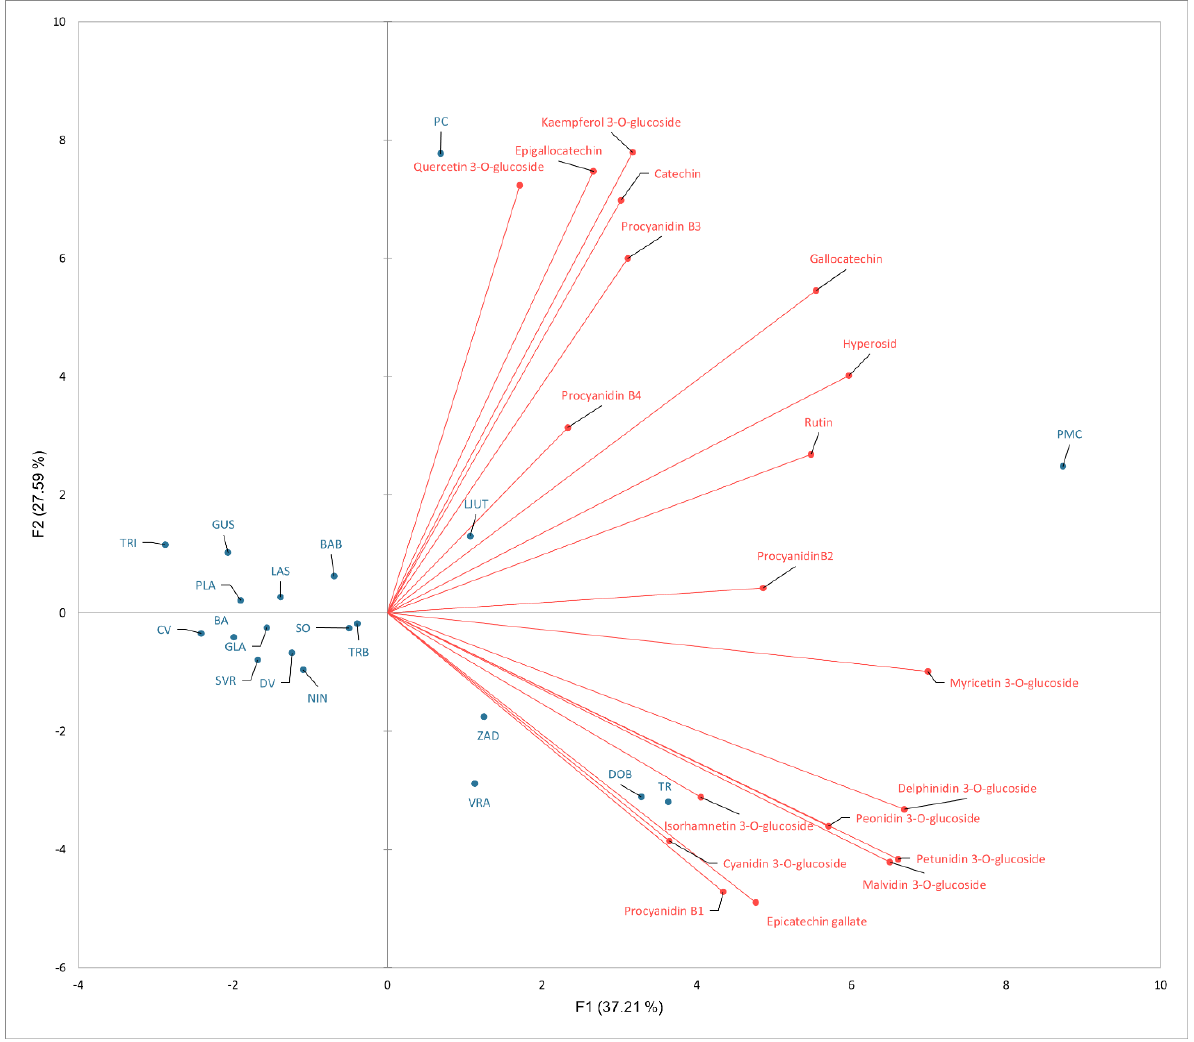
Figure 1. The scatter plot representing the differentiation of varieties based on PCA and related vector diagram of polyphenolic compounds contributing to the differentiation.